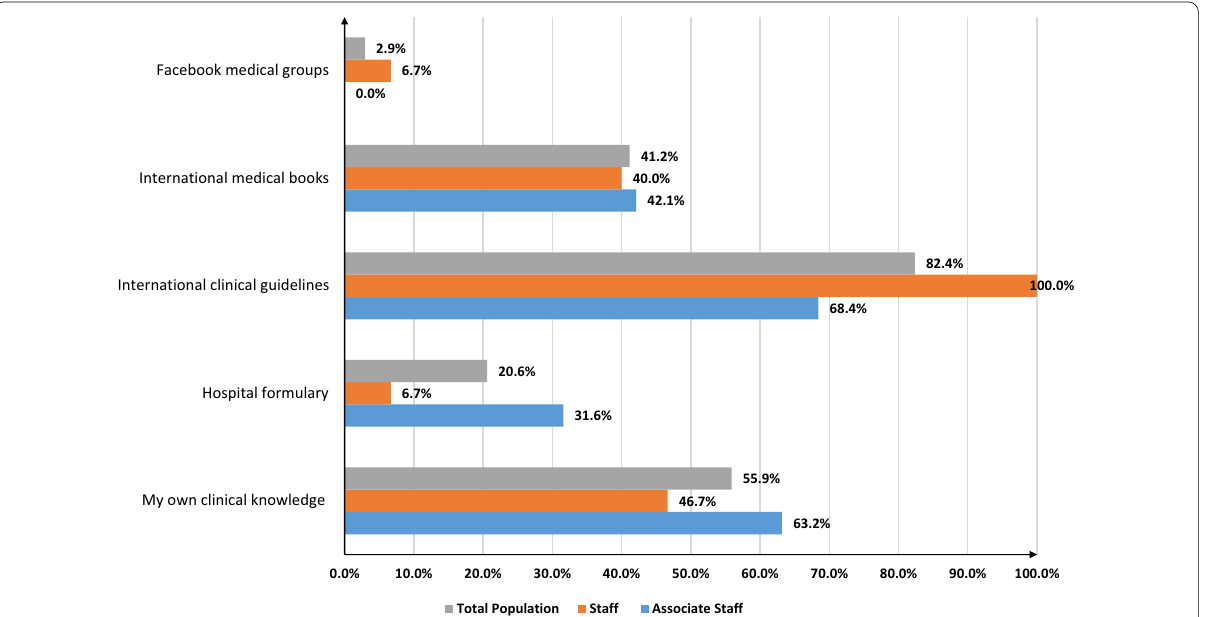
Fig. 1 Information sources for prescribing heart failure guideline-directed medicines. Survey question: What information sources guide you for prescribing heart failure medicines? You may choose more than one option. Data are presented as total respondents, staff (specialists and consultants), and associate staff (junior and senior